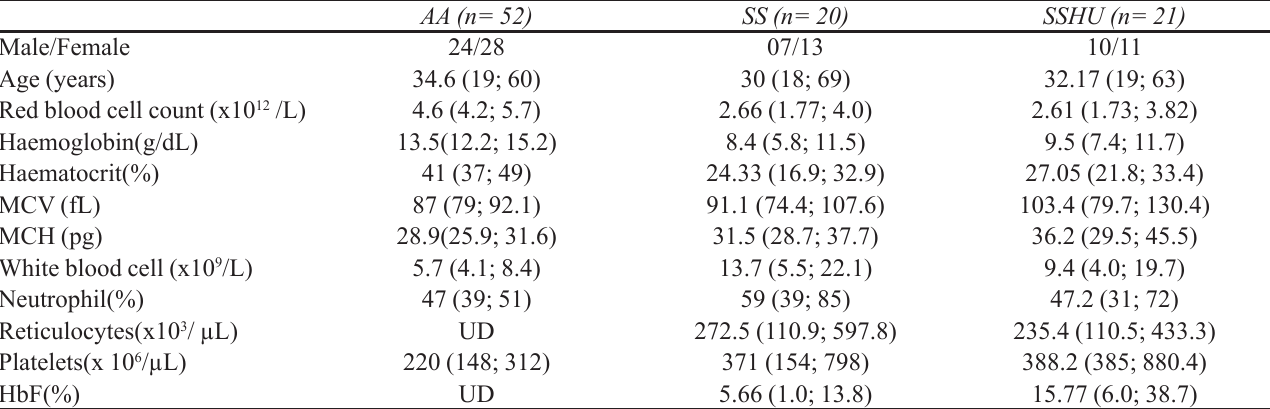
TABLE I -Characteristics and clinical details of the control group and patients with sickle cell anemia participating in the